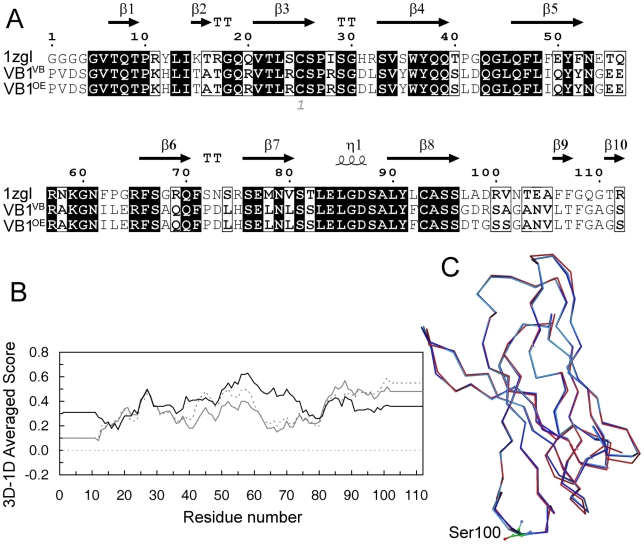
Modeling of TCR-VB1VB and TCR-VB1OE domains.A) Sequence alignment of VB1VB and VB1OE with 1zgl Vβ domain. Alignments were performed with ClustalW algorithm and ESPript software. Identical and similar amino acids are in dark and white boxes, respectively. The secondary structural elements are shown aligned to their respective sequences. Numbering of amino acids begins with the first amino acid residue of sequenced VB1VB and VB1OE; B) Residue-based quality assessment results obtained by the Verify3D program using the coordinates of 1zgl crystal structure (black) and the coordinates of the three-dimensional models of VB1VB and VB1OE (continuous grey and dashed grey, respectively). X axis: amino acid numbering of VB1VB and VB1OE starting from the first sequenced residue. Y axis: average three/one-dimensional scores for residues in a 21-residue sliding window; C) Cα trace of VB1VB (dark blue) and VB1OE (light blue) model structures superimposed onto the Cα trace of template 1zgl Vβ domain (red). Ser100, at the apex of CDR3 loop of VB1VB and VB1OE, is shown in ball and stick representation.